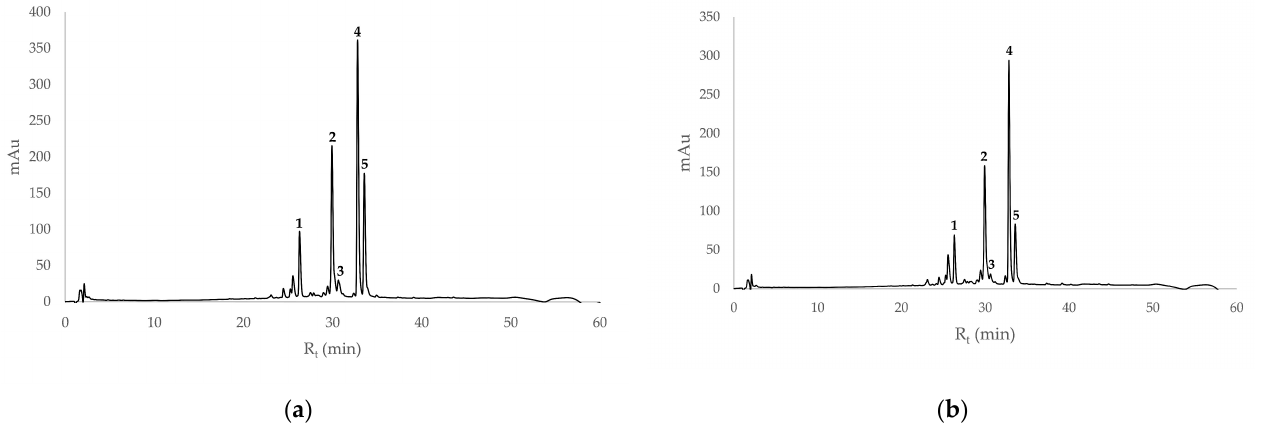
Figure 2. HPLC chromatogram of sea buckthorn juice from Tuscany ( a ) and from Friuli-Venezia Giulia ( b ) at 360 nm. Peak 1 had a mass spectrum with a base peak of 787.2327 m/z and a secondary peak of 463.1246 m/z . Peak 2 had a mass spectrum with a single peak of 625.1782 m/z . Peak 3 had a mass spectrum with a base peak of 303.0511 m/z and a secondary peak of 465.1051 m/z . Peak 4 had a mass spectrum with a base peak of 625.1776 m/z and two secondary peaks of 479.1198 m/z and 317.0654 m/z . Peak 5 had a mass spectrum with a base peak of 317.0646 m/z and two secondary peaks of 479.1191 (M+H) and 501.1024 (M+Na). Table 2. Accurate mass, exact mass, and concentrations ( µ g/mL) of each peak-correspondent polyphe- nolic compound found in the two the two tested sea buckthorn juices. SBT: sea buckthorn Tuscany, Italy; SBF: sea buckthorn Friuli-Venezia Giulia,